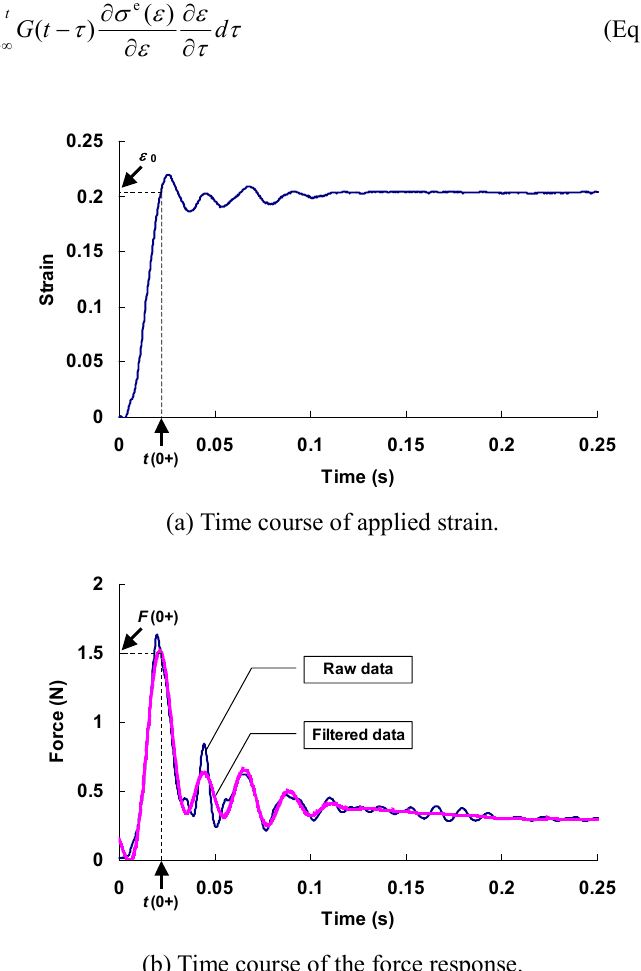
Fig. 5: Typical example of a relaxation test result during initial 0.25